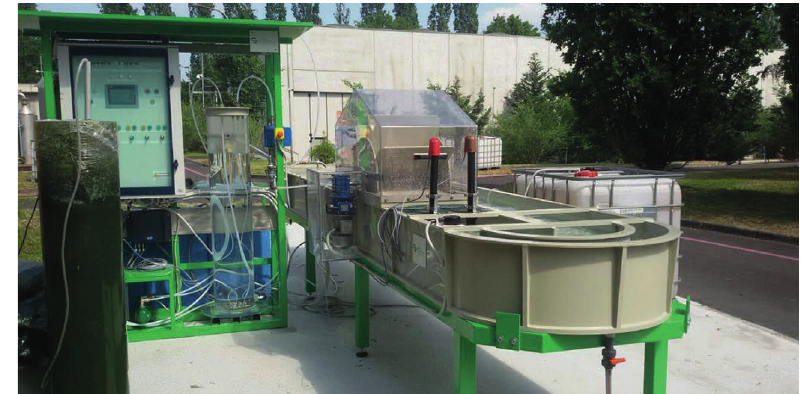
Fig. 1. Pilot raceway for testing MBP in Bresso-Niguarda